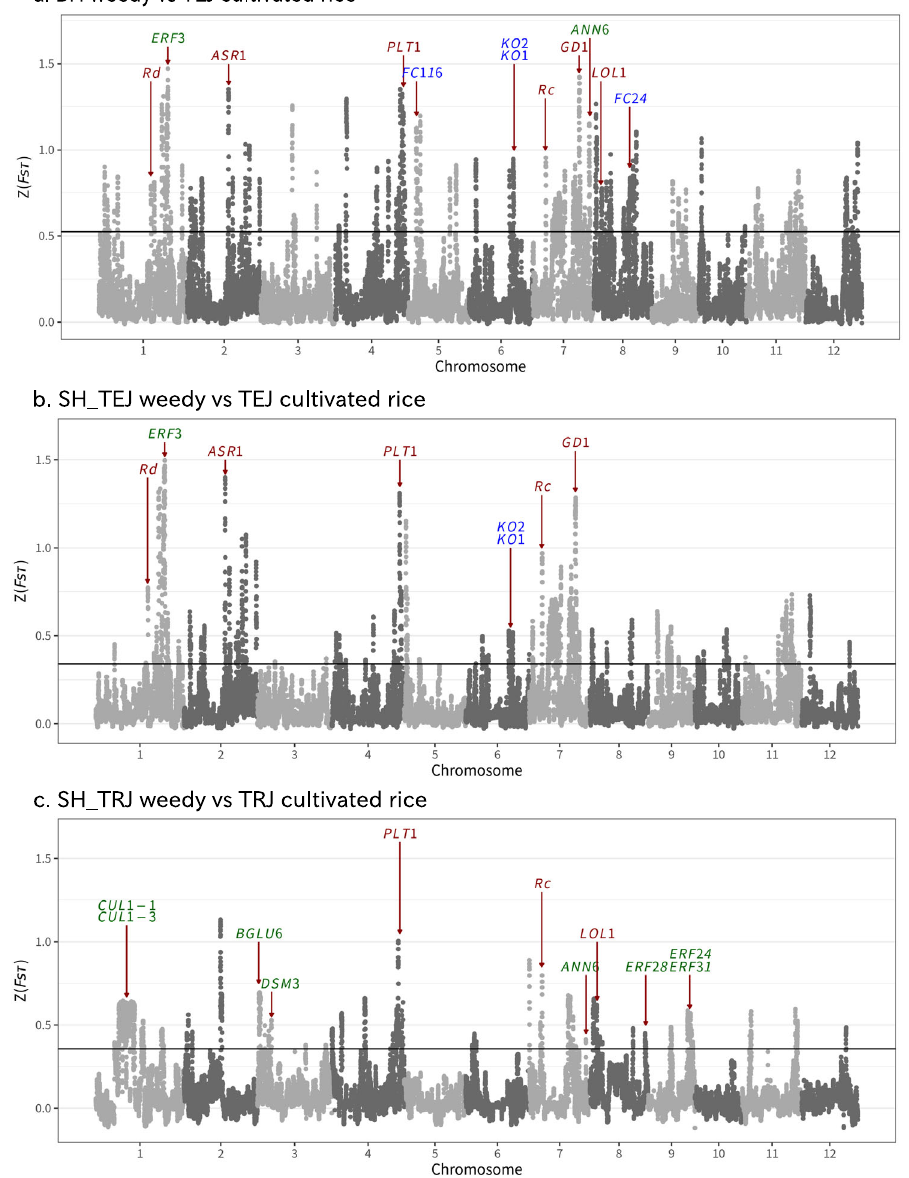
Fig. 3 Genomic regions under selection in weedy rice. F ST ( Z -transformed) between TEJ cultivated rice and BH and SH_TEJ weedy rice ( a , b , respectively) and between TRJ cultivated and SH_TRJ weedy rice ( c ). TEJ cultivated rice includes both modern and landrace strains. Each dot is a 100-kb window with a step size of 10 kb, and the solid line indicates the cut-off for the threshold of fi ve absolute median deviations. Signi fi cant windows that were located continuously were integrated to outlier regions, and 162, 133 and 96 outlier regions were detected in ( a ), ( b ) and ( c ), respectively. Some functionally known genes locatied in the signi fi cant regions are shown: that regulating a red pericarp colour and/or seed dormancy in dark red, that regulating drought tolerance in green, and that regulating plant height and/or endogenous bioactive gibberellins in